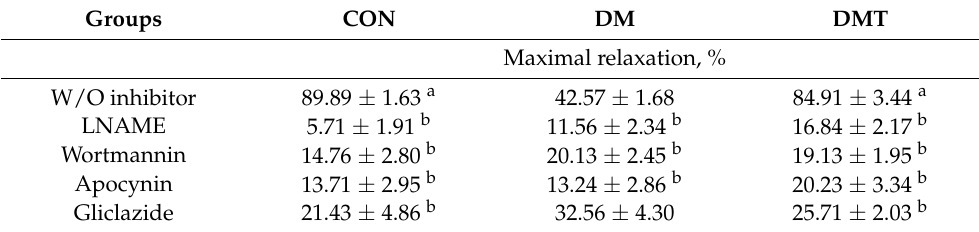
Table 1. Percentage of maximal relaxations to acetylcholine in the rat aorta.